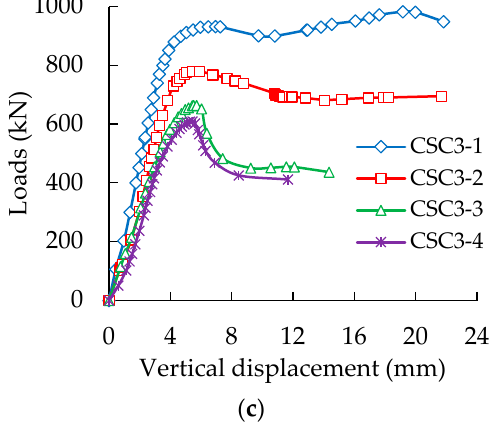
Figure 4. Load vertical displacement behavior of CFST specimens with different corrosion ratios. ( a ) t = 0.92 mm; ( b ) t = 1.42 mm; ( c ) t = 1.92 mm.